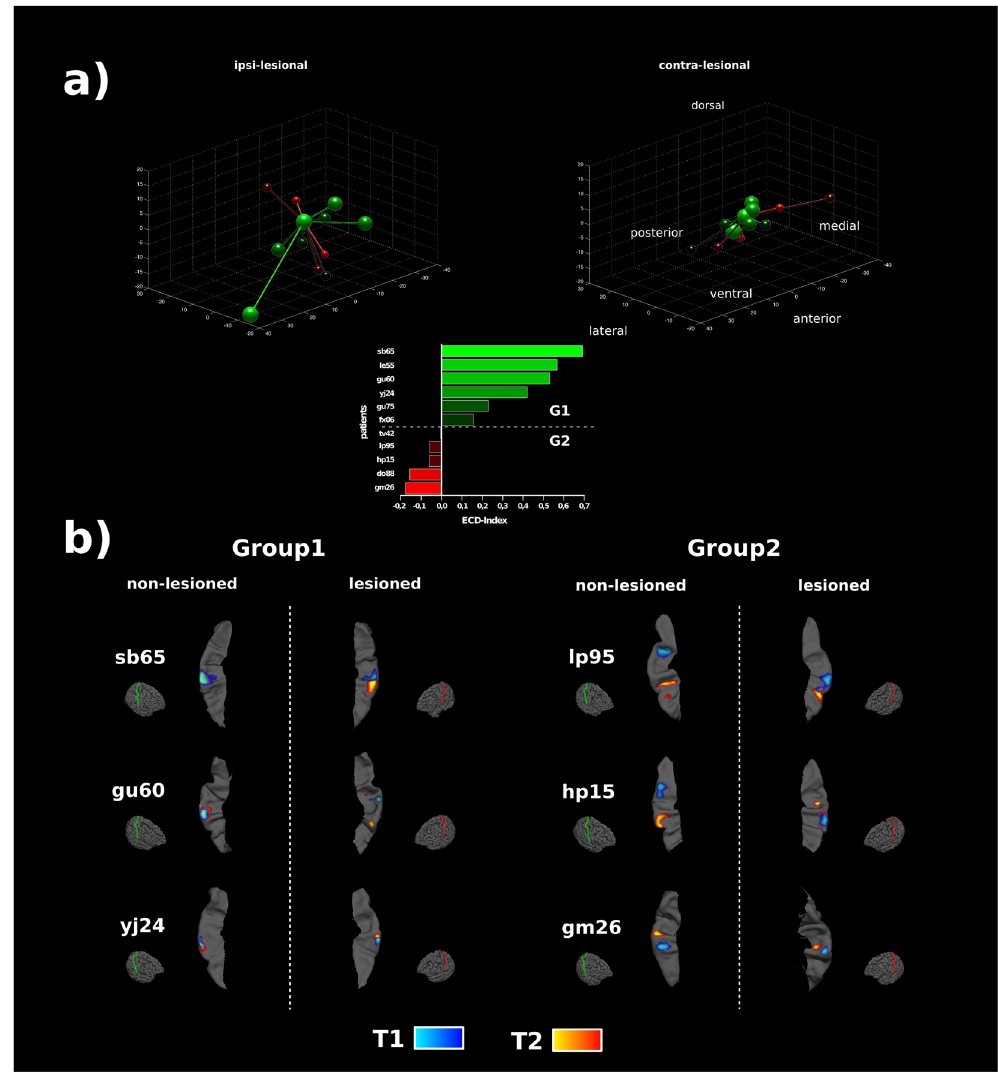
Figure 3. Source localizations. Ipsi- and contralesional source displacements over time ( a ) based on the equivalent single current dipole model. Absolute displacements of sources of all patients within a common space. [0, 0, 0] at both sides denotes the dipole position at the time of the first MEG measurement (T1) in each patient. Larger relative displacements over time for the ipsilesional hemisphere are colored in green shades while larger contralesional displacements are colored in red shades. The bar plot below illustrates the relative dipole displacements over time for each single patient. The ECD-Indices show more negative values for larger displacements contra-lesional and more positive values for larger displacements within the ipsilesional hemisphere. ( b ) Results of the individual distributed source modeling on realistic cortex models. The maximum of the source estimates for T1 and T2 is shown on the ipsi- and contralesional postcentral gyrus. Hemispheres are flipped in that the left side illustrates the lesioned hemisphere in all